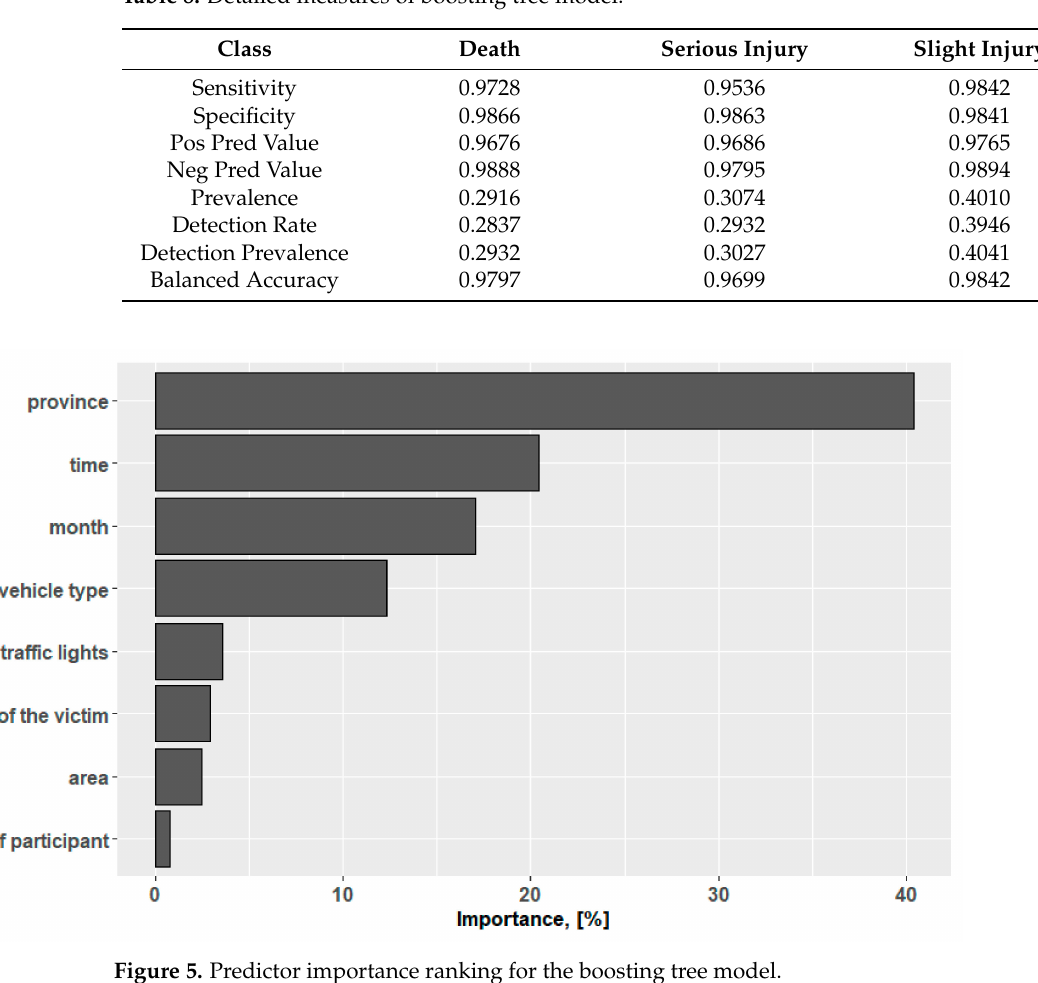
Figure 5. Predictor importance ranking for the boosting tree